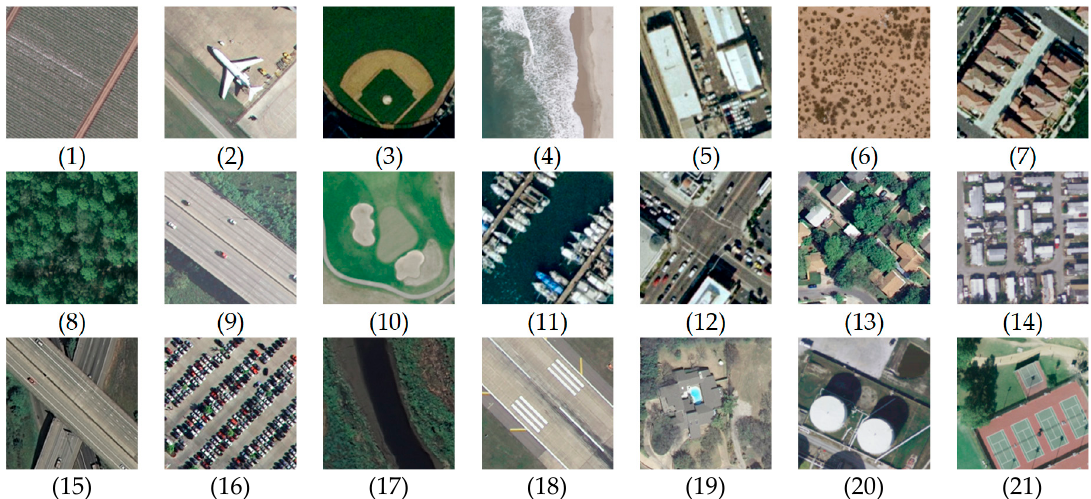
Figure 2. Example images of UC Merced Land ‐ Use dataset: (1) agriculture; (2) airplane; (3) baseball diamond; (4) beach; (5) buildings; (6) chaparral; (7) dense residential; (8) forest; (9) freeway; (10) golf course; (11) harbor; (12) intersection; (13) medium residential; (14) mobile home park; (15) overpass;